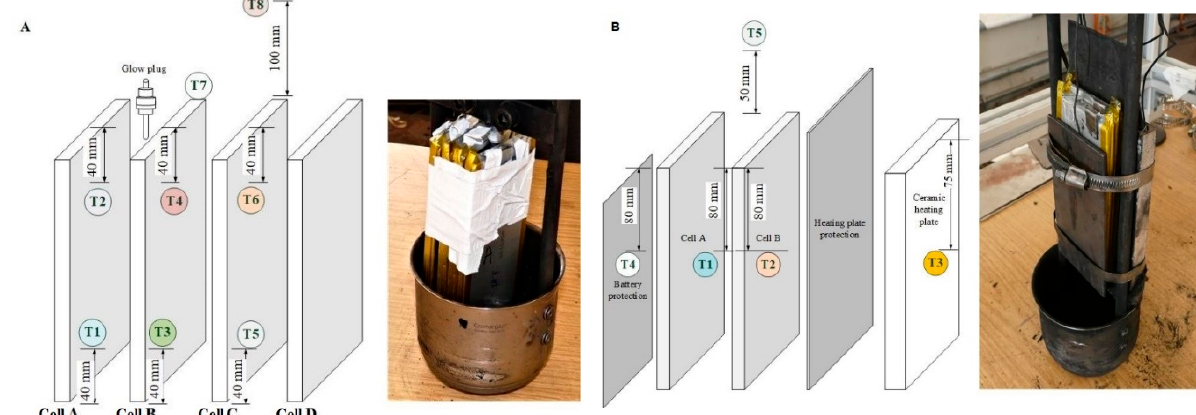
Figure 5. ( A ) Sketch of the reactor vessel; ( B ) schematic diagram illustrating the experimental setup.